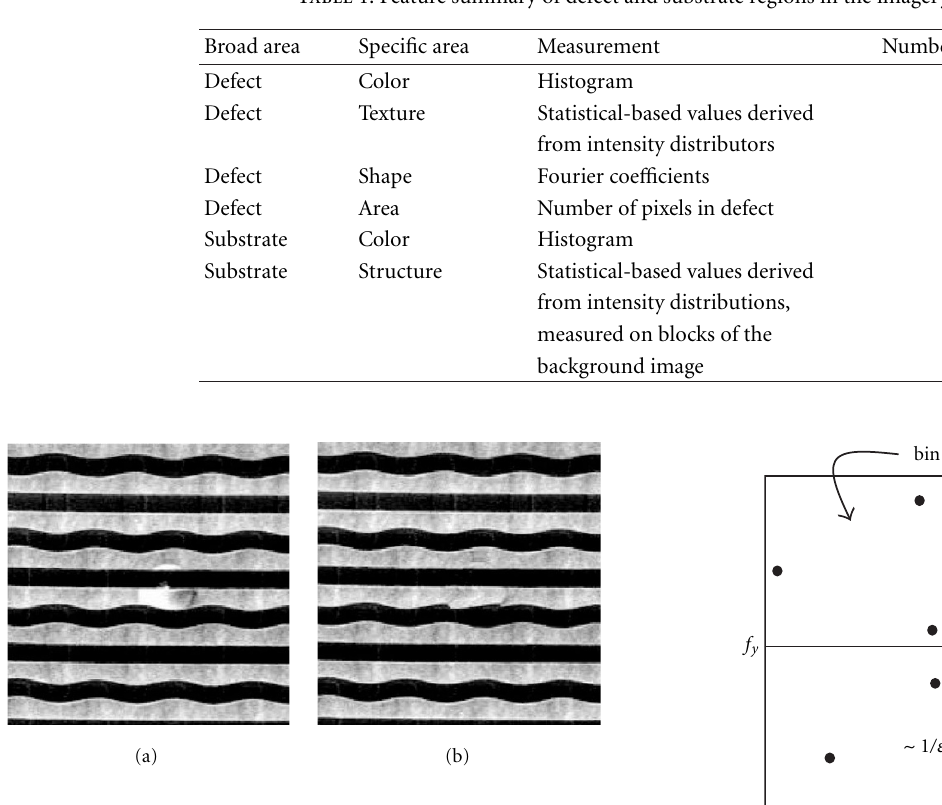
Figure 3: Example of an image with defect in (a) and the estimated “filled” version used to estimate substrate feature measurements in (b).